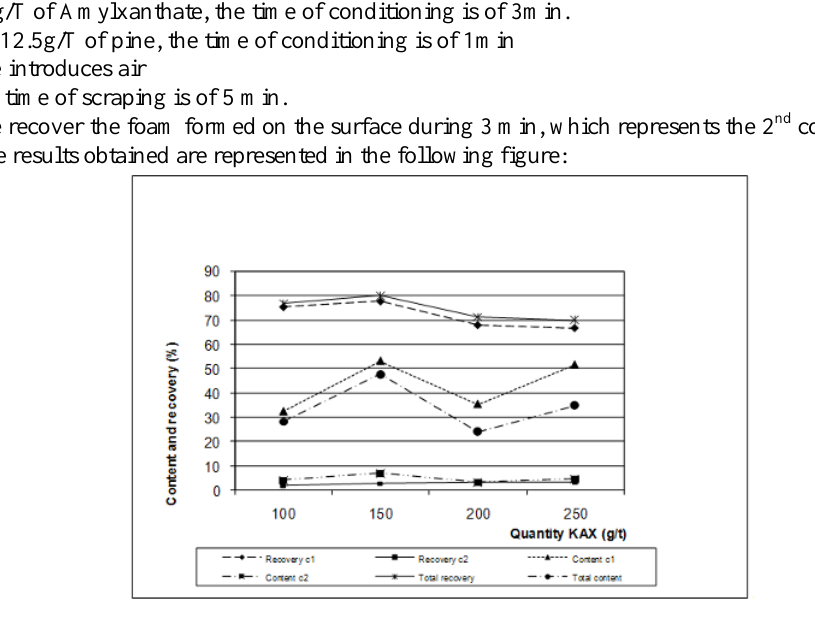
Fig. 4. Curve 4. Content and recovery of